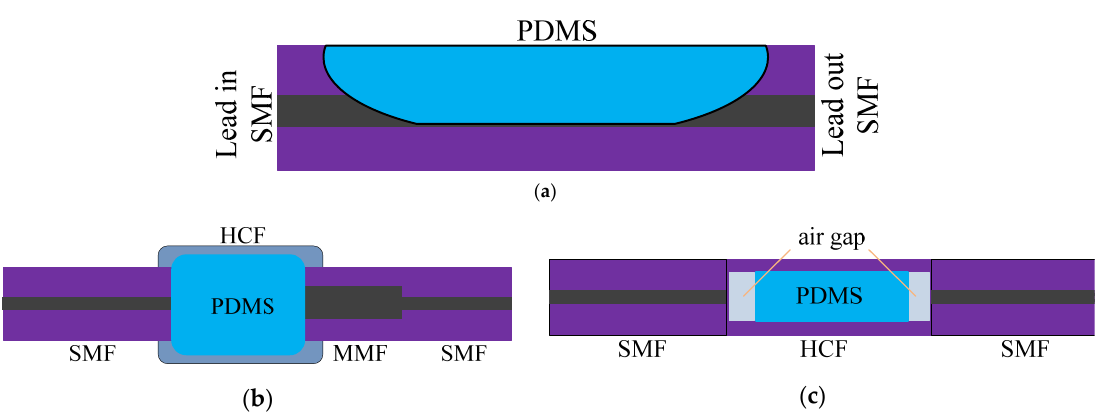
Figure 4. The sensors were filled with PDMS: ( a ) D-shaped fiber coated with PDMS [28]; ( b ) Hollow core fiber filled with PDMS [29]; ( c ) Hollow core fiber filled with air gap-PDMS-air gap [30].